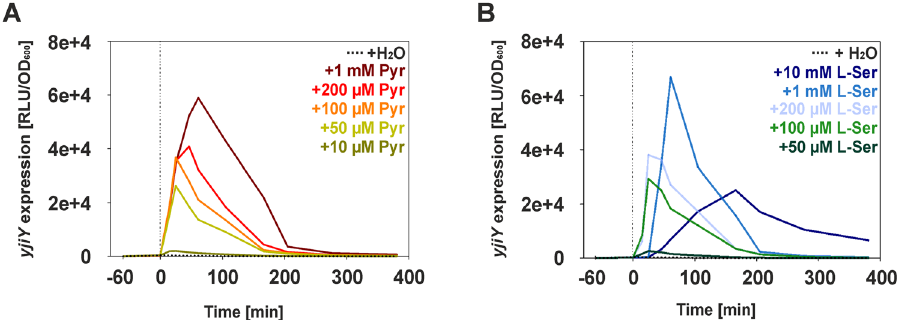
Figure 4. Stimulus-dependent yjiY expression under nutrient-limiting conditions. E . coli MG1655 mutant Δ yhjX harboring pBBR yjiY - lux was cultivated in 0.1x LB medium to establish low nutrient conditions. After 1 h (time point 0), the indicated concentration of pyruvate ( A ), or L-serine ( B ), or the equivalent volume of water was added. Experiments were performed at least three times (standard deviation < 10%), and results of a representative experiment are